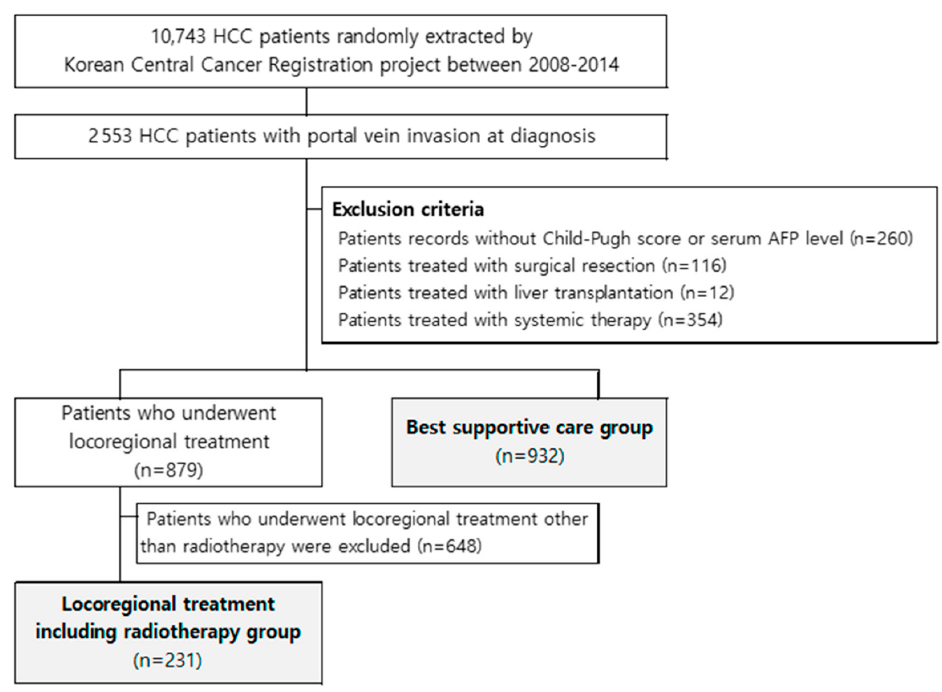
Figure 1. Patient selection process.